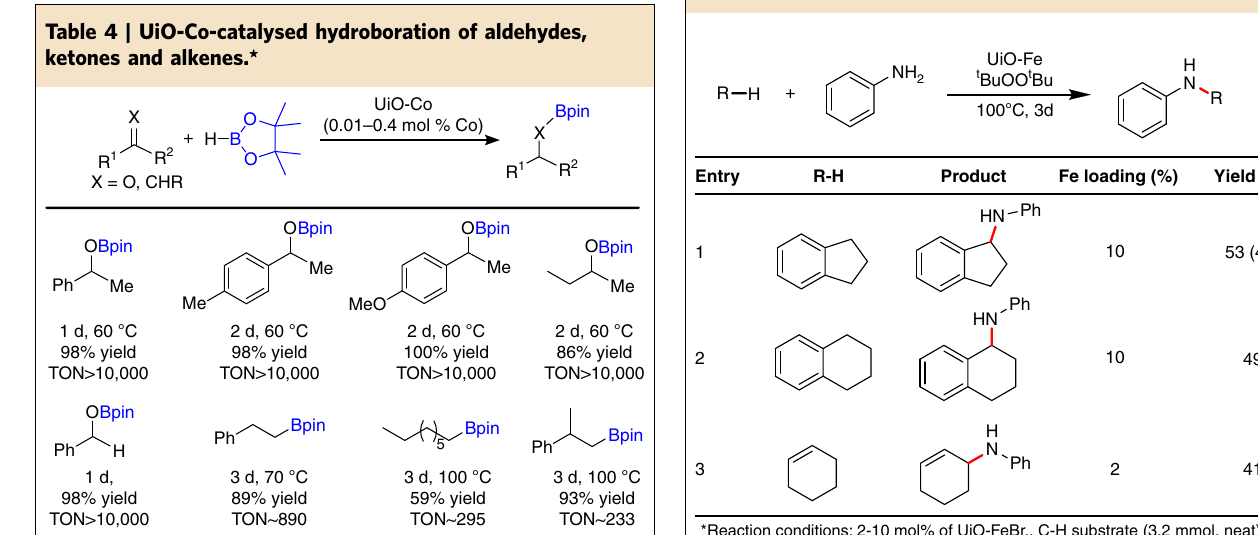
Table 5 | UiO-FeBr-catalysed sp 3 C–H amination.*